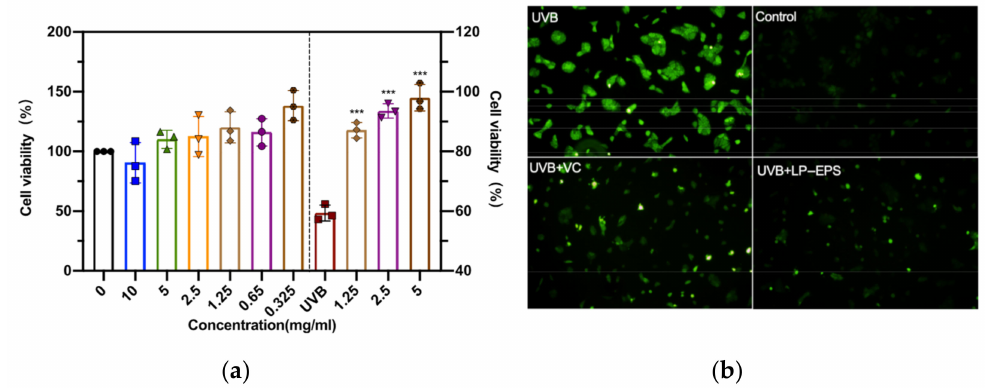
Figure 4. Cell experiments: ( a ) HaCaT cell viability: toxicity test (left) and protective effect test (right); ( b ) fluorescence intensity photo of ROS in HaCaT cells. ***: p < 0.001.